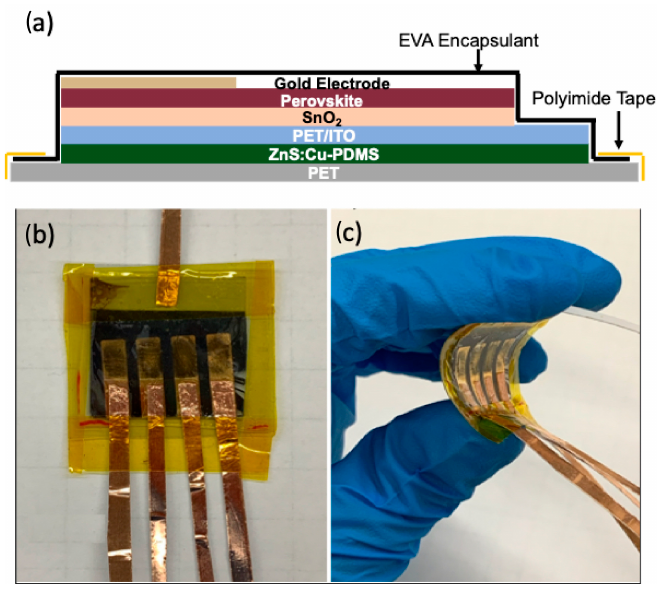
Figure 3. ( a ) Schematic of the encapsulated device; ( b ) top and ( c ) side view of the device.